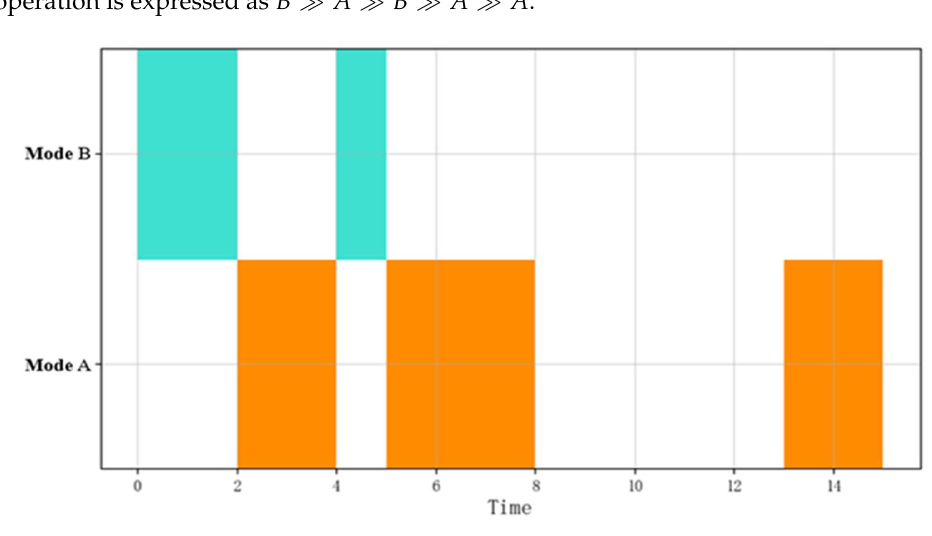
Figure 3. Visualization of the sequential combination of event flows.